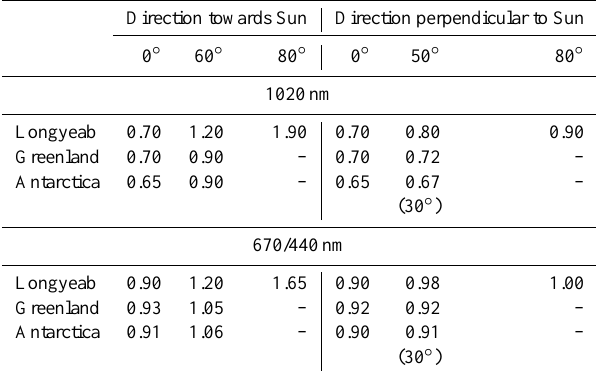
Table 1. Comparison of reflectances taken in situ at Longyearbyen (this paper), and from space by PARASOL over Greenland and Antarctica (Kokhanvosky and Breon,